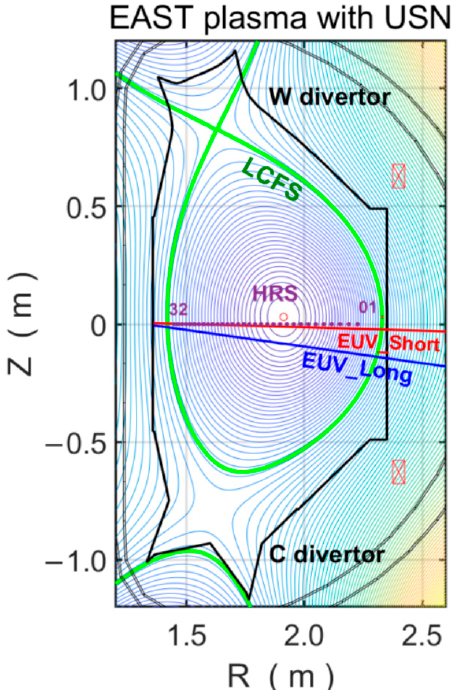
Figure 2. EAST poloidal cross ‐ section, lines of sight of EUV spectrometers (EUV_Short: red line and EUV_Long: blue line) and position of ECE measurement (purple points, HRS01–HRS32), channels of 01–32 are from low field side (LFS) to high field side (HFS). The red rectangles indicate the cross section of magnetic coils.